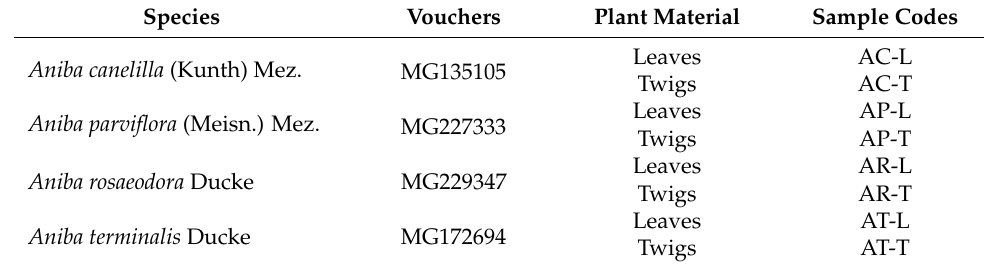
Table 3. Data from Aniba species. Species Sample